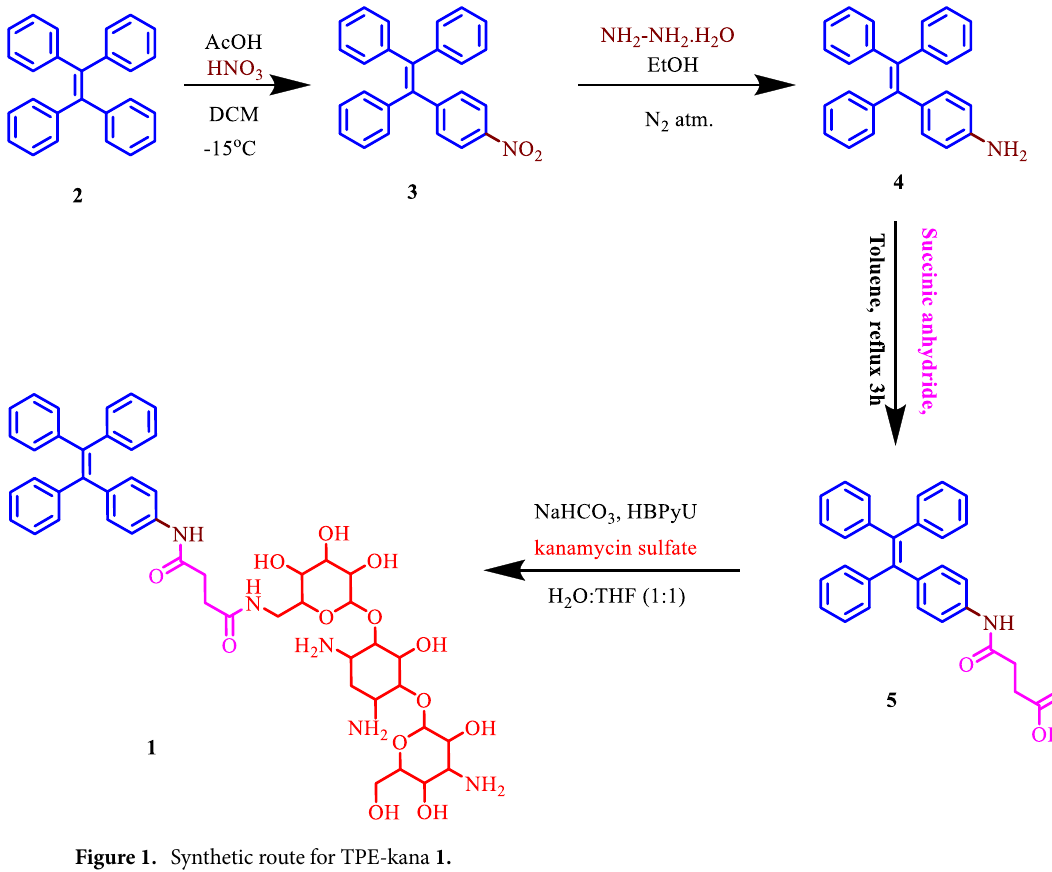
Figure 1. Synthetic route for TPE-kana